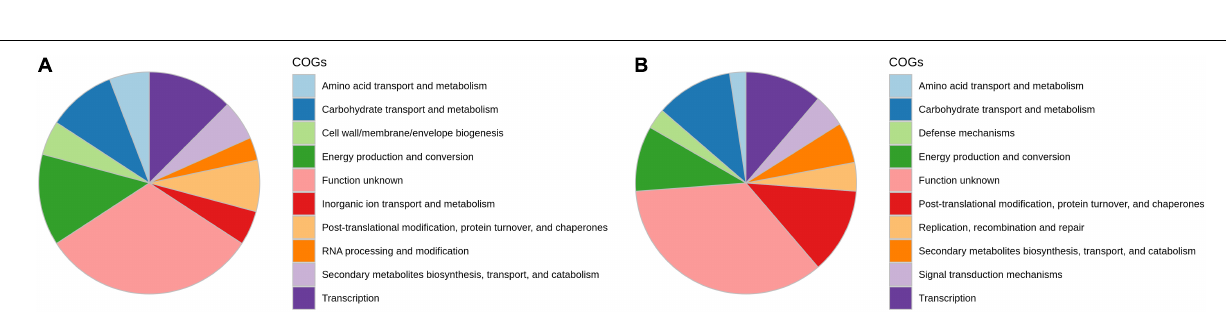
Frontiers in Plant Science |